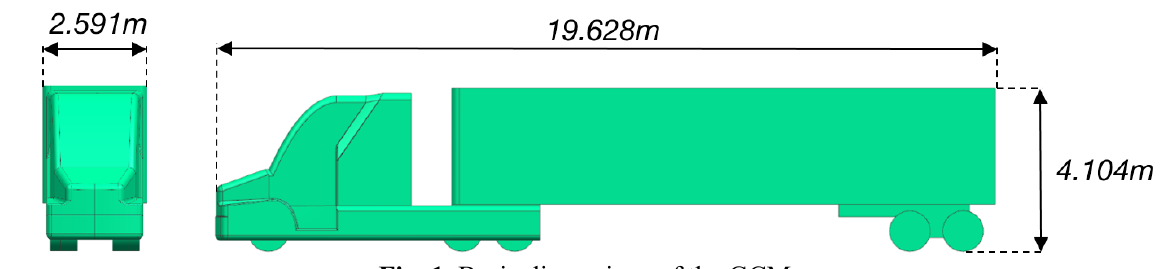
Fig. 1. Basic dimensions of the